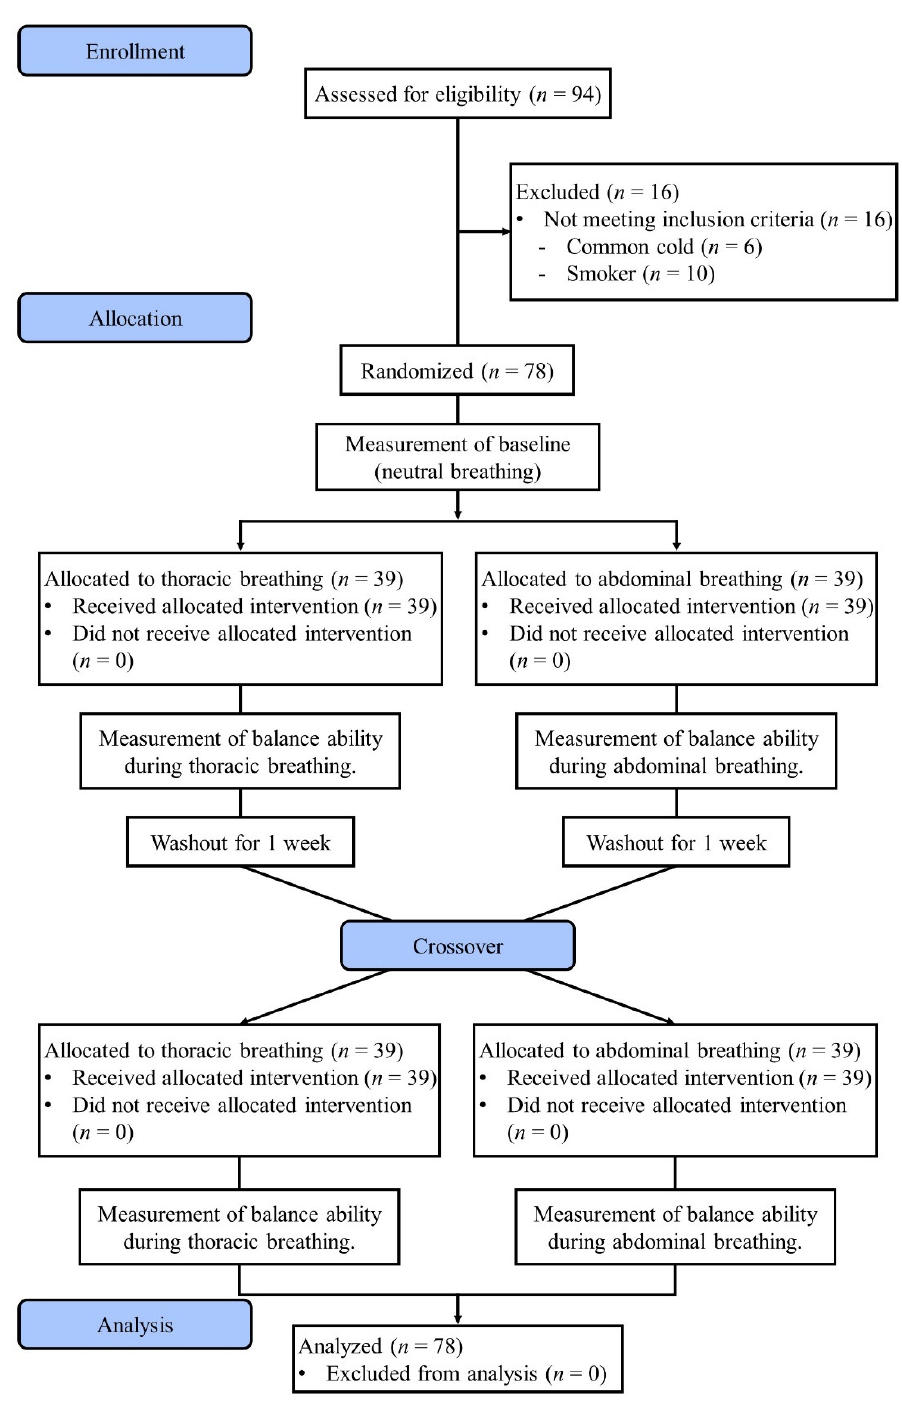
Figure 1. A CONSORT flow diagram with crossover design.